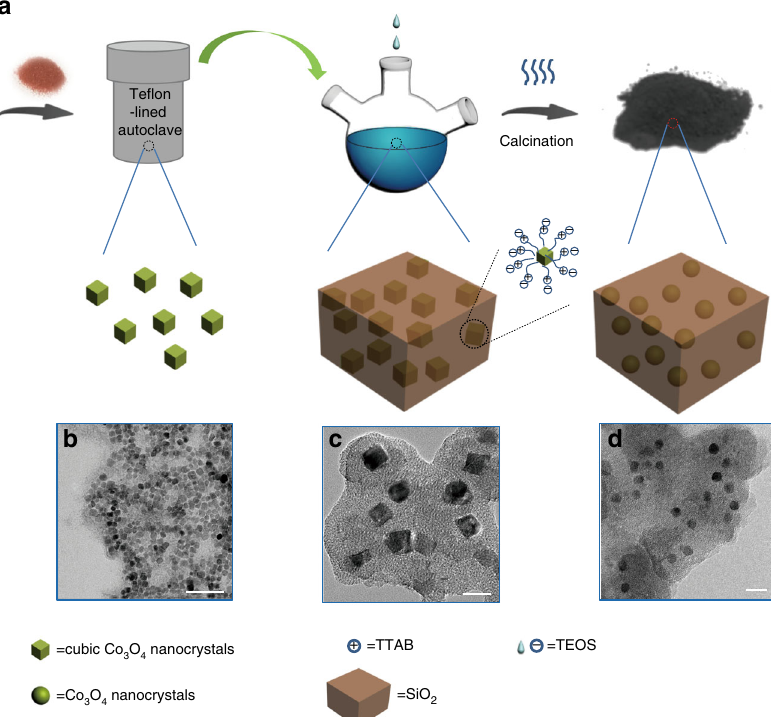
Fig. 1 Synthesis of the Cat- x h catalysts. a Schematic illustration of the synthesis of the Co 3 O 4 nanocrystals with the narrow size distribution and the preparation of the Cat- x h catalysts with the uniform size distribution. b – d TEM images of the materials containing Co 3 O 4 hydrothermal-synthesized for 8 h. b TTAB-capped Co 3 O 4 nanocrystals. c Co 3 O 4 -TTAB-silica nanocomposite. d Cat-8h. Scale bars: b 50 nm; c 10 nm; d 20